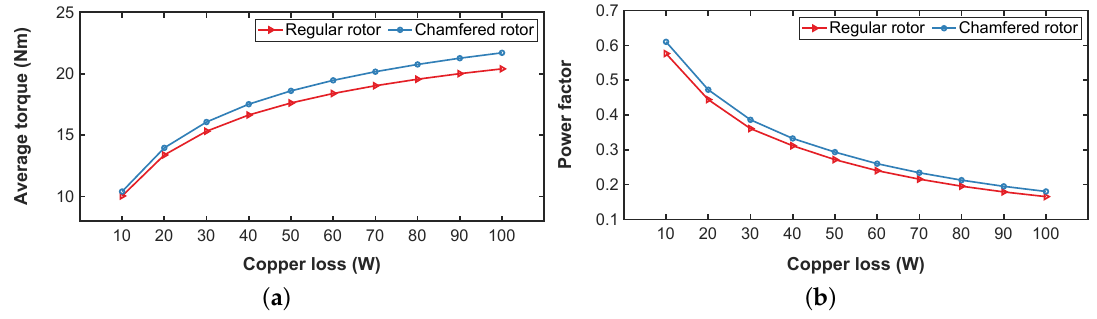
Figure 9. Over-loading capability of both candidates. ( a ) Average torque; ( b ) Power factor.